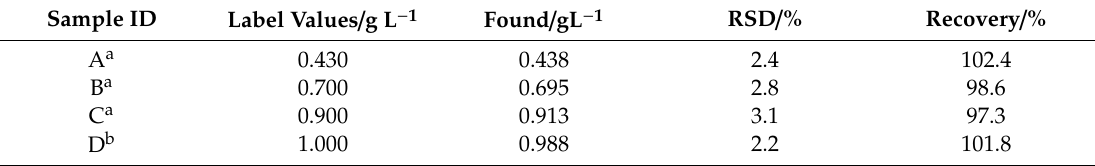
Table 2. The results for the determination of Trp in compound amino acid injections ( n = 4).